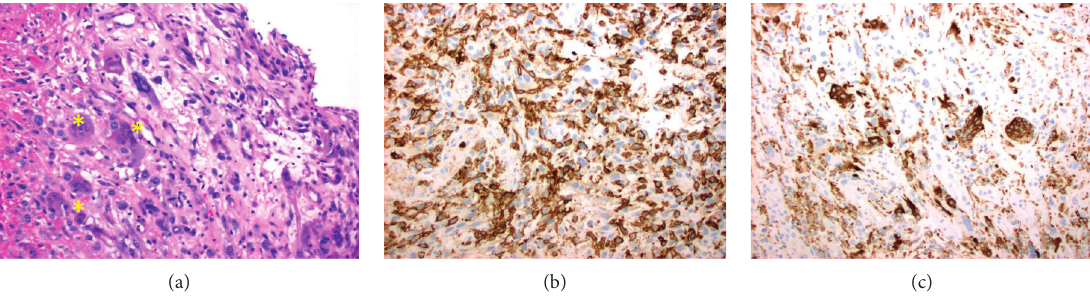
Figure 1: Initial endoscopic biopsy of tumor at 20x magnification. (a) Microscopic endoscopic biopsy hematoxylin and eosin stain results showed giant cells ( ∗ ) and interspersed atypical epithelioid and spindle cells. Endoscopic biopsy stained with CD45 (b) and CD68 (c) immunohistochemistry staining in lymphocytes. CD45 was positive in background lymphocytes but negative in atypical cells, and CD68 was positive in giant